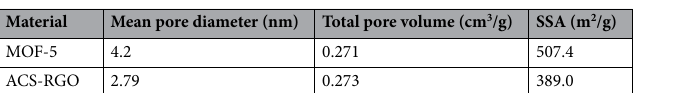
Table 1. The physicochemical properties for MOF-5 and